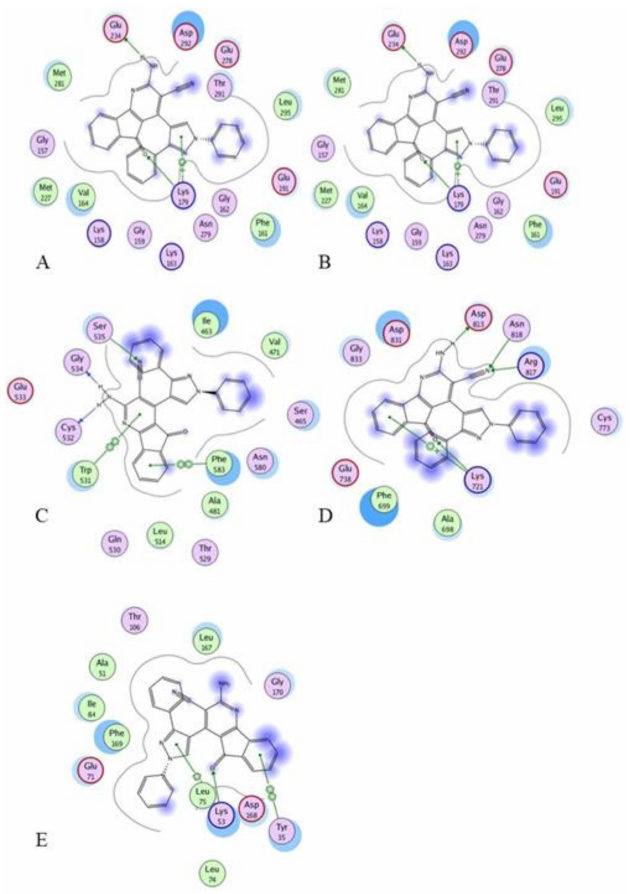
Figure 100. Putative binding interactions of compound 97 with AKT1 ( A ), AKT2 ( B ), V600E-B-RAF